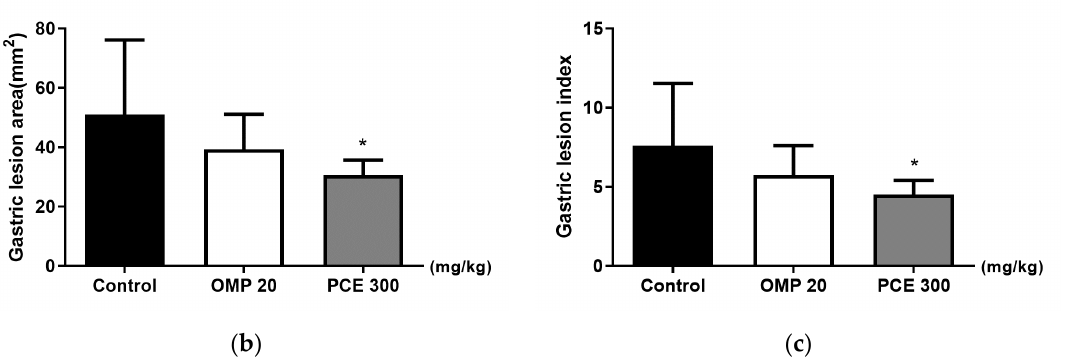
Figure 4. Healing e ff ects of PCE on gastric ulcers induced by acetic acid. ( a ) Representative macroscopic images of stomachs from each group. Rats were treated orally twice a day with distilled water (control), OMP (20 mg / kg), or PCE (300 mg / kg) after surgery. Quantification of gastric lesion area ( b ) and gastric lesion index ( c ). Values are expressed as mean ± standard deviation. n = 8–10 per group. * p < 0.05 vs. control by Kruskal–Wallis test with Dunn’s multiple comparisons test. OMP, omeprazole; PCE, P. cuspidatum extract.